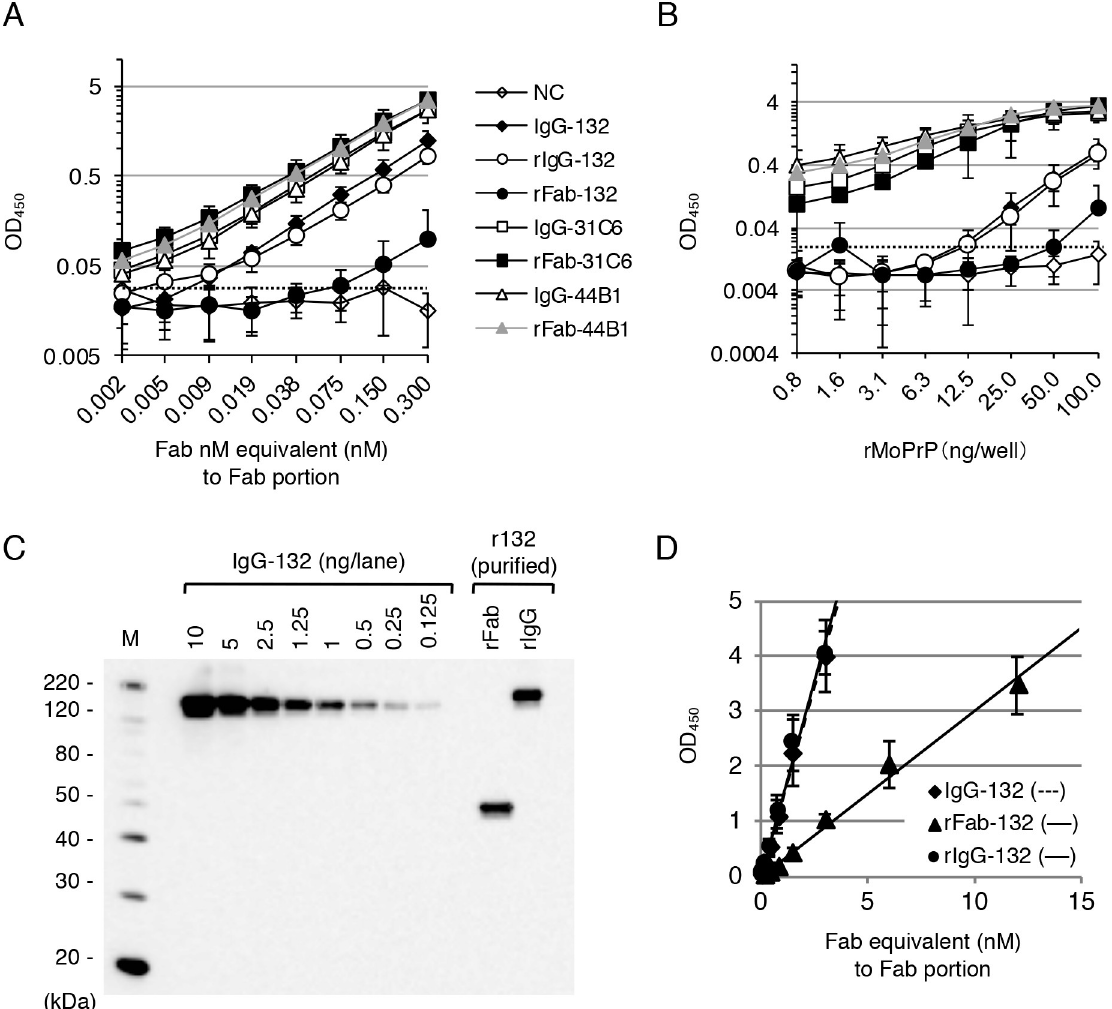
Fig 2. Reactivity of recombinant antibodies in ELISA. (A) Reactivity of authentic and recombinant antibodies. Twofold serially diluted antibodies (0.002–0.3 nM Fab equivalent) were added to wells coated with 100 μ g/well rMoPrP. Purified IgG was used for authentic mAbs, whereas the supernatant of HEK293T cells transfected with each expression plasmid was used for recombinant antibodies after estimation of concentrations equivalent to the Fab portion by immunoblot analysis using serially diluted purified IgG as a standard. Reactivities of authentic IgG and rIgG of mAbs 132, 31C6, and 44B1 as well as their rFab fragments are shown. Mean absorbances at 450 nm and SD (three independent experiments) are plotted. The supernatant of HEK293T cells transfected without any plasmids was used as a negative control (NC). Dotted line indicates a cutoff value calculated by the average plus 3 × SD. (B) Antigen concentration-dependent reactivity of authentic and recombinant antibodies. Twofold serially diluted rMoPrP (0.8–100 ng/well) was adsorbed to wells. For detection of rMoPrP, 0.3 nM antibodies equivalent to the Fab portion were used. (C) Quantification of purified rFab-132 and rIgG-132. Concentrations of recombinant antibodies were estimated by comparing 2-fold serially diluted authentic IgG-132 (0.125–10 ng). Blot was probed with an HRP-conjugated anti-mouse IgG (Fab specific) (Sigma), and signal intensities were quantified using Image Gauge software (Fujifilm). (D) Difference in reactivity of monovalent (rFab-132) and bivalent (IgG-132 and rIgG-132) forms of mAb 132. ELISA was carried out using 100 ng/well rMoPrP as an antigen and twofold serially diluted purified rFab-132 (0.09–12 nM), IgG-132, and rIgG-132 (0.02–3 nM) as primary antibodies.